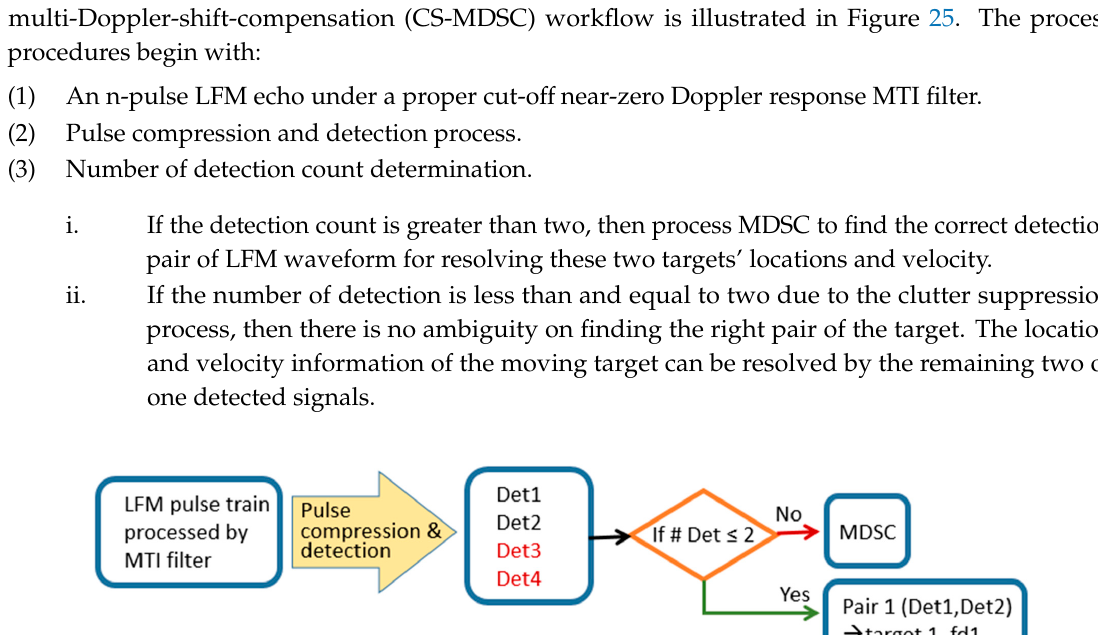
Figure 24. A 3-pulse MTI filtered echo of two overlapped targets. Target one is near-zero-Doppler, while the target-two velocity is at Mach 15.